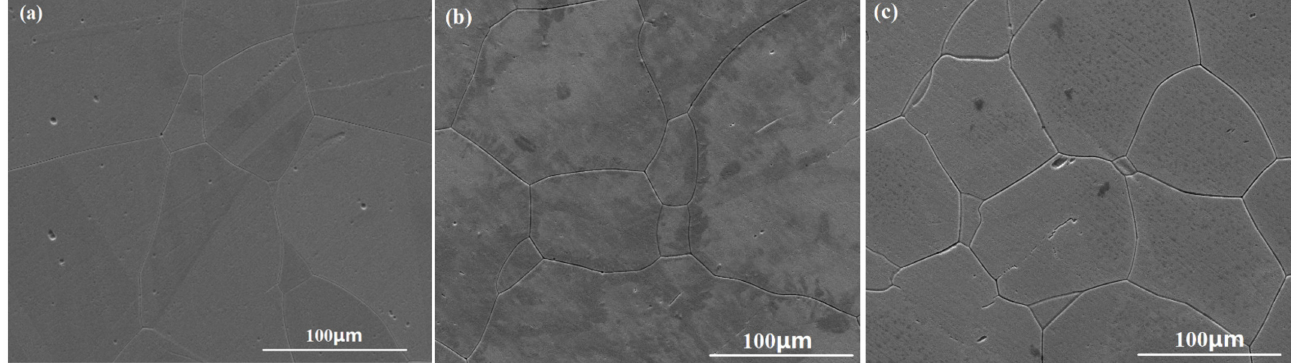
Figure 12. Corroded morphologies of the C22 alloy after potentiostatic polarization at 600 mV mse 50 ◦ C ( a ), 600 mV mse 60 ◦ C ( b ) and 600 mV mse 70 ◦ C ( c